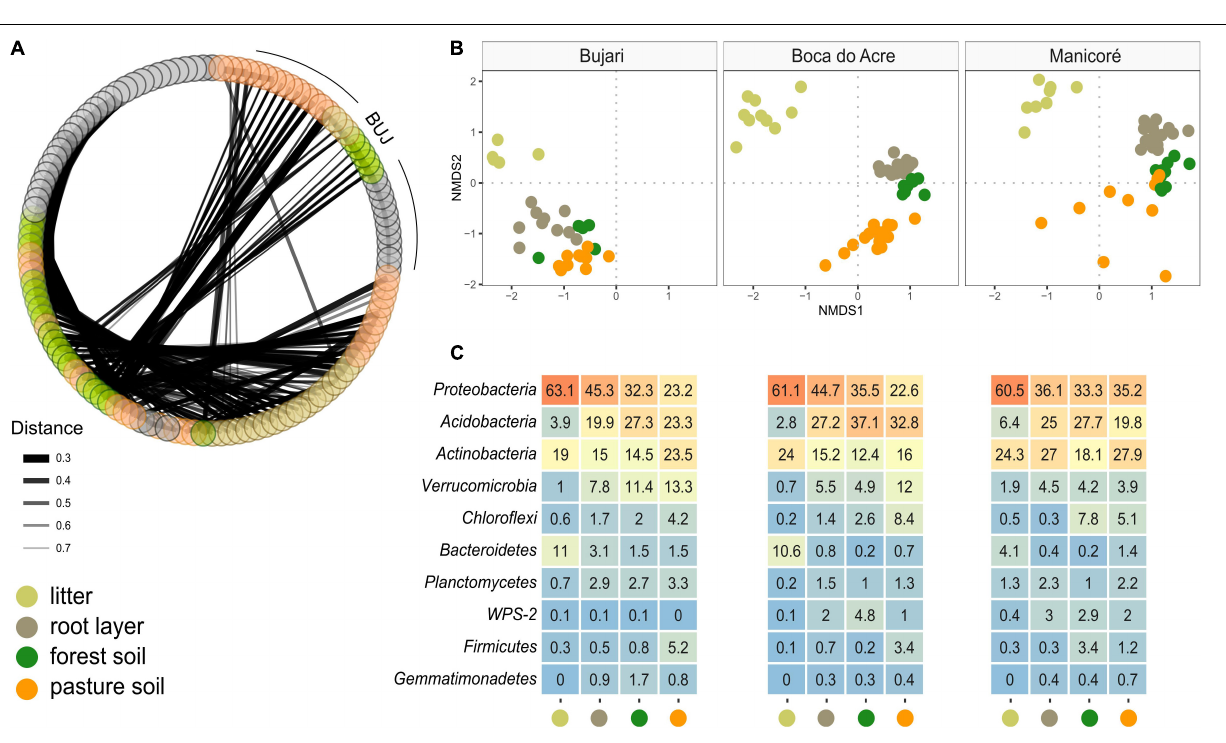
FIGURE 3 | Co-occurrence of prokaryotic metacommunity between sites based on forest floor compartments and pasture bulk soil. (A) Co-occurrence based on compartments (litter, root layer, forest, and pasture soil) and study sites; the thickness of the links is proportional to the strength of the interactions; (B) NMDS by compartments and sites (BUJ, BAC, and MAN); distance measured by Bray–Curtis based on the abundance of ASVs from each sample point; (C) relative abundance of Bacteria (phylum level) in compartments of forest floors and pasture